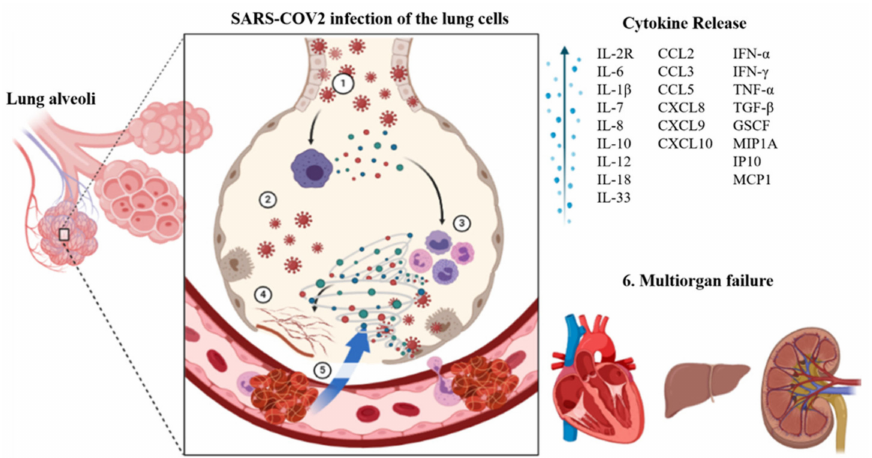
Figure 1. SARS-CoV-2 infection of lungs leading to cytokine storm resulting in multi-organ